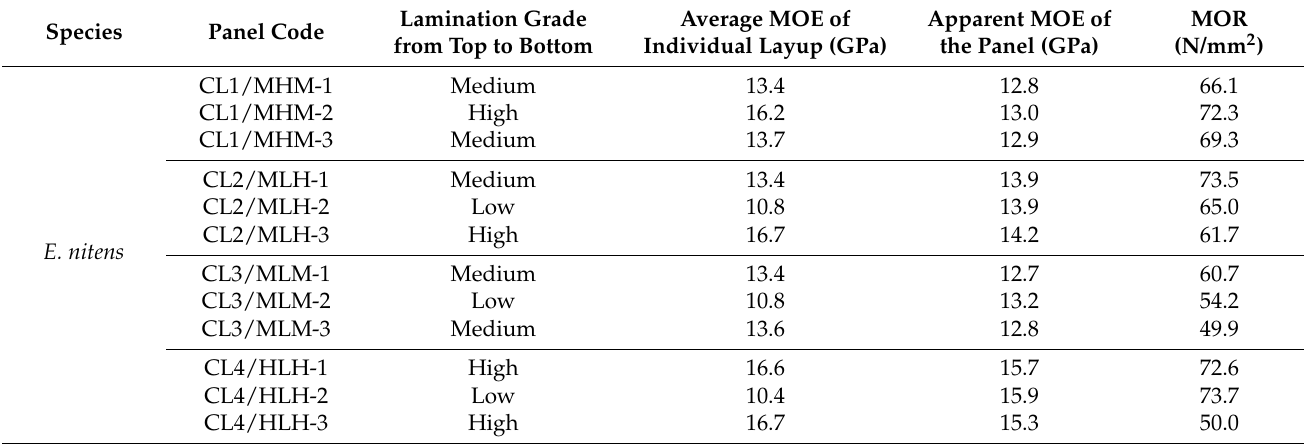
Table 1. Summary of CLT panel properties and bending test